Question: Based on the figure, does the quantity rise or fall?
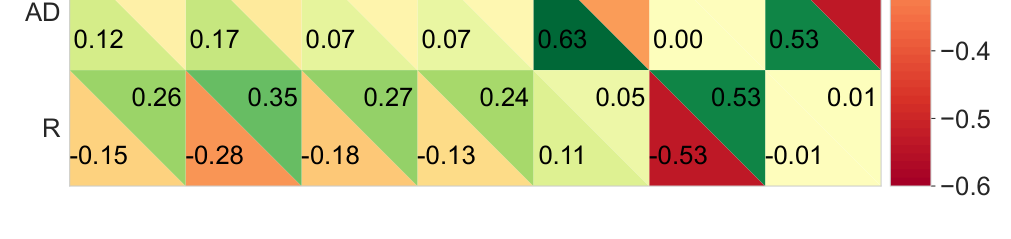
Answer: increasing